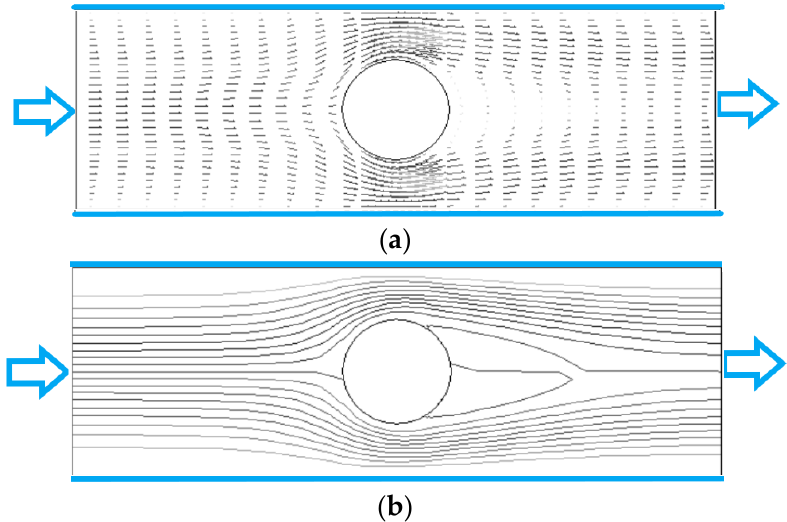
Figure 4. Fluid velocity vector and streamline of flow (Re = 200, n = 0.7). ( a ) velocity vector. ( b ) streamline.